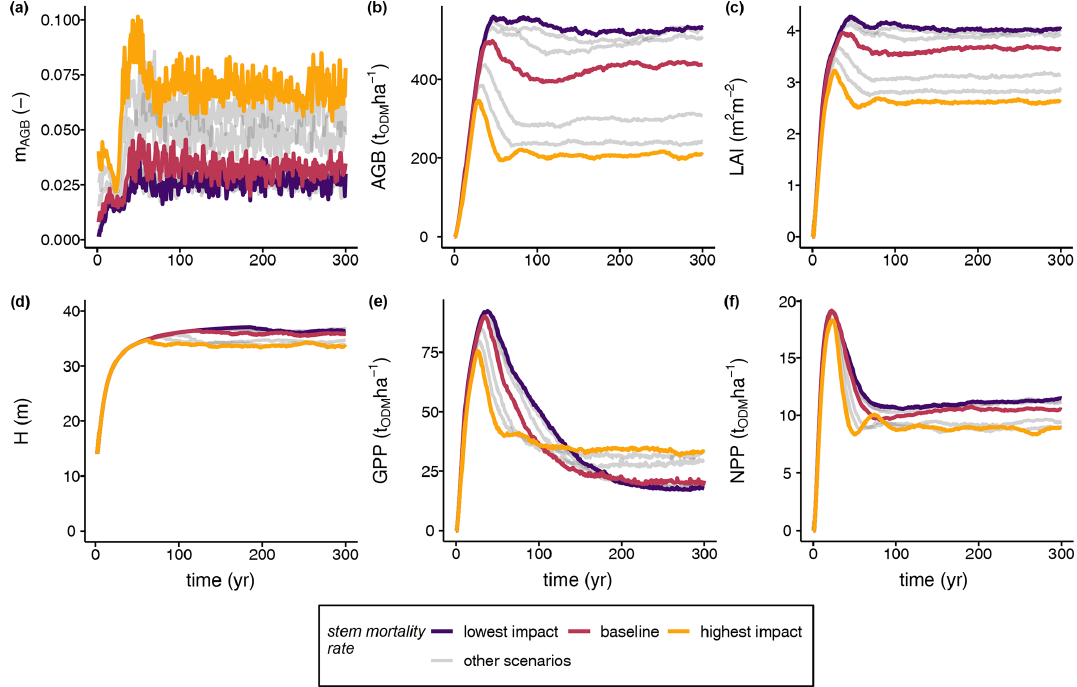
Figure 3. Simulation results of the (a) biomass loss rate ( m AGB ), (b) aboveground biomass (AGB), (c) leaf area index (LAI), (d) mean forest height ( H ), (e) gross primary production (GPP), and (f) net primary production (NPP) of terra firme forest stands under different stem mortality intensities. Grey lines indicate the entire set of scenarios under varying stem mortality rates (Eq. 1) (ODM: organic dry matter; for further details see Table 1, Figs. S2 and S3).